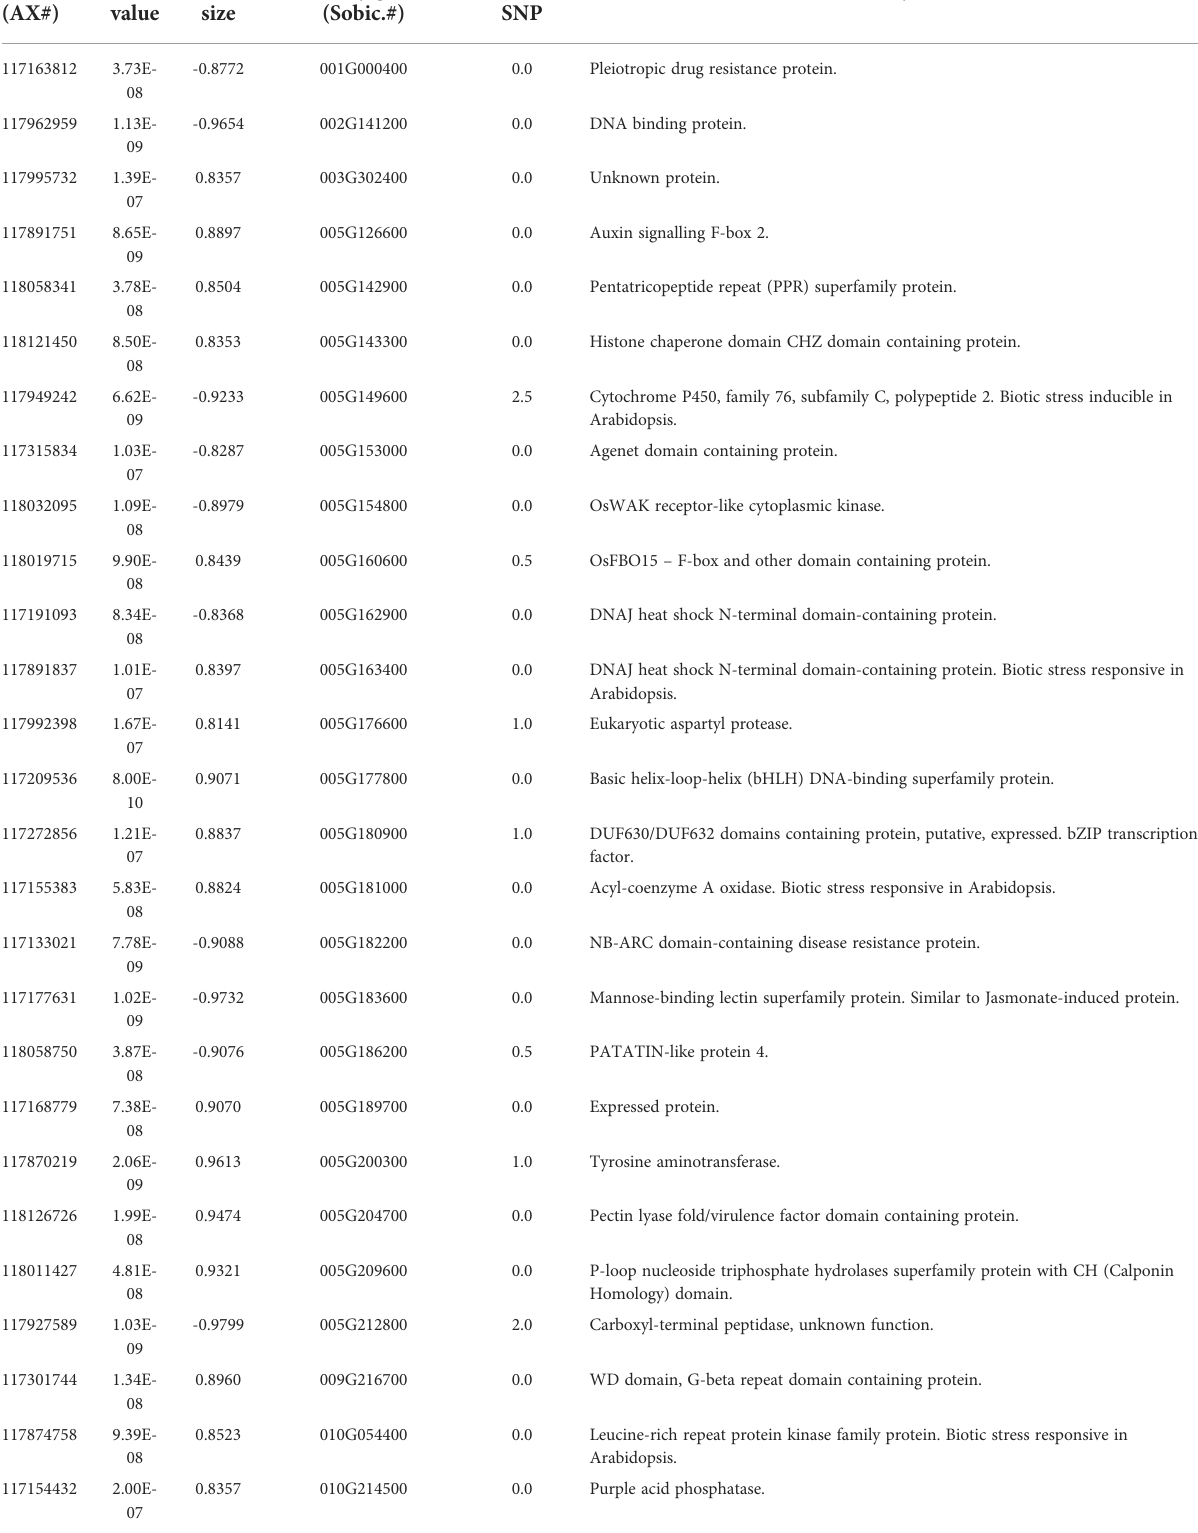
TABLE 2 Genes co-located with red rot resistance associated